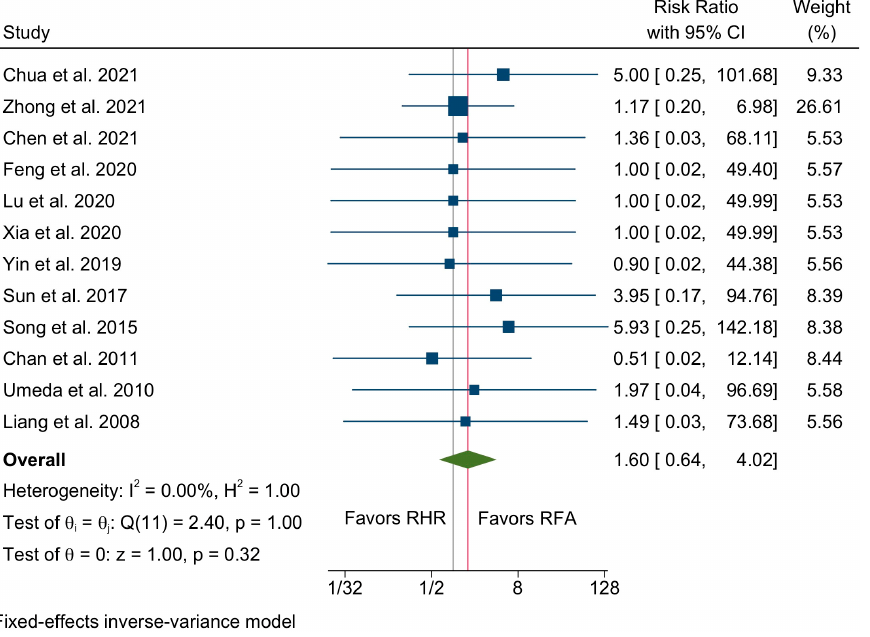
Figure 7. Forest plot of overall mortality between the RHR and RFA groups [22,23,25,27,29 – 32,34,36 –